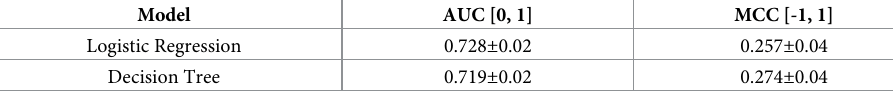
Table 2. AUC and MCC values (mean ± CI) obtained by Logistic Regression and Decision Tree .